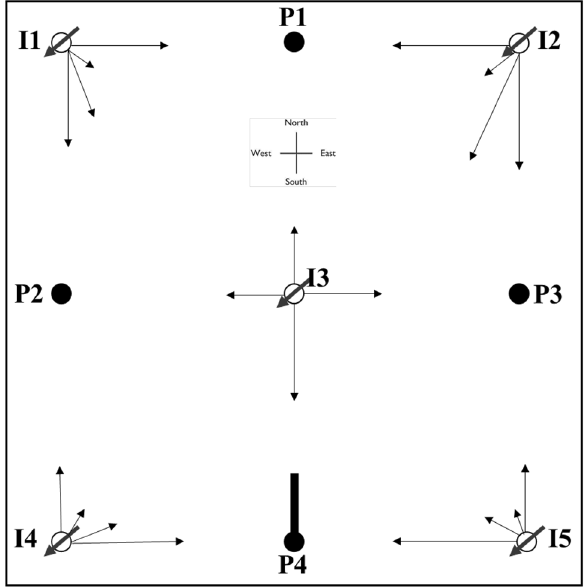
Fig. 18 Distribution of f ij in case IV, where P 4 is horizontally drilled toward the North. Each black arrow and its length represent the con- nectivity and magnitude,